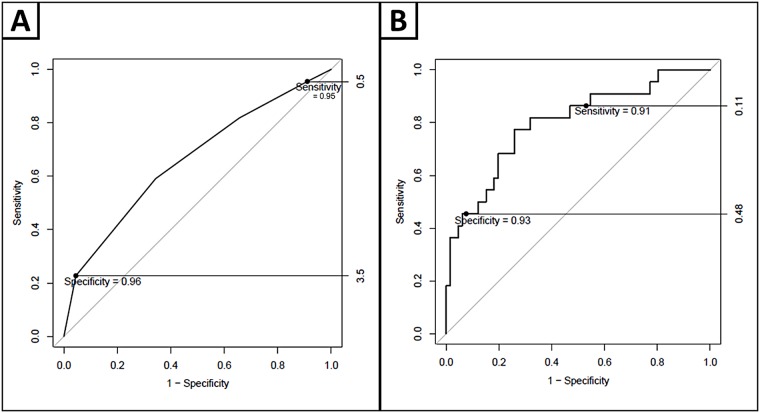
ROC curves displaying DOC apnea diagnostic cut-points, for high sensitivity and specificity and diagnostic cut-points with a logistic regression applied, controlling for age, sex and BMI.